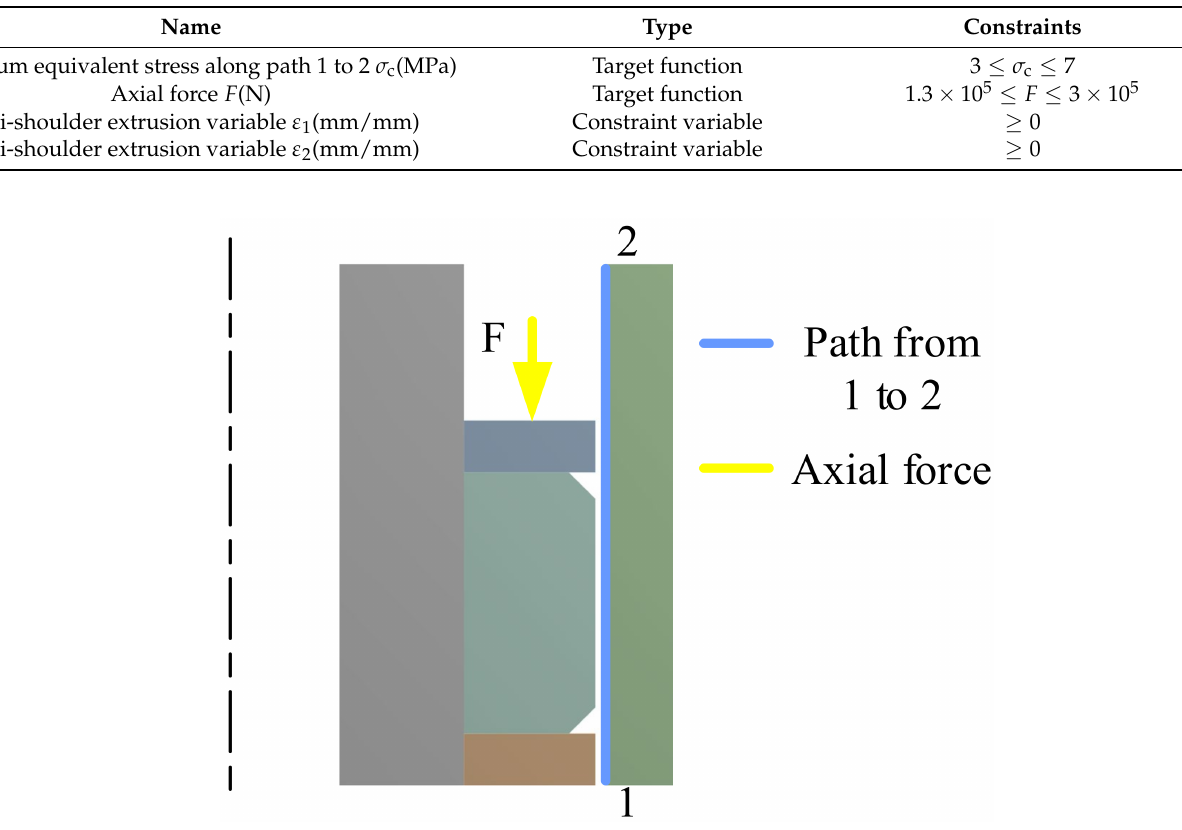
Figure 7. Diagram of target